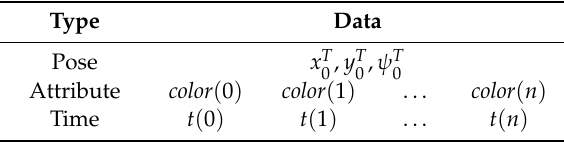
Table 5. Example of a tra ffi c light as the time-varying attribute object.